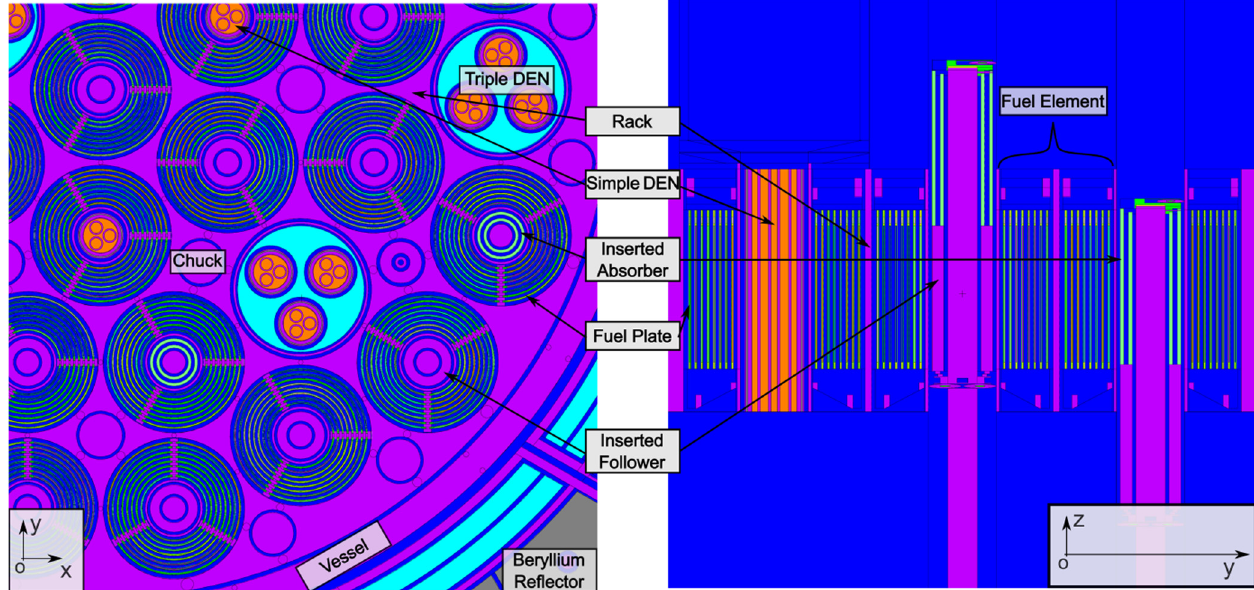
Fig. 2. Core components description view. Grey is for beryllium, blue for water, purple for aluminum, turquoise blue for zircaloy and orange for